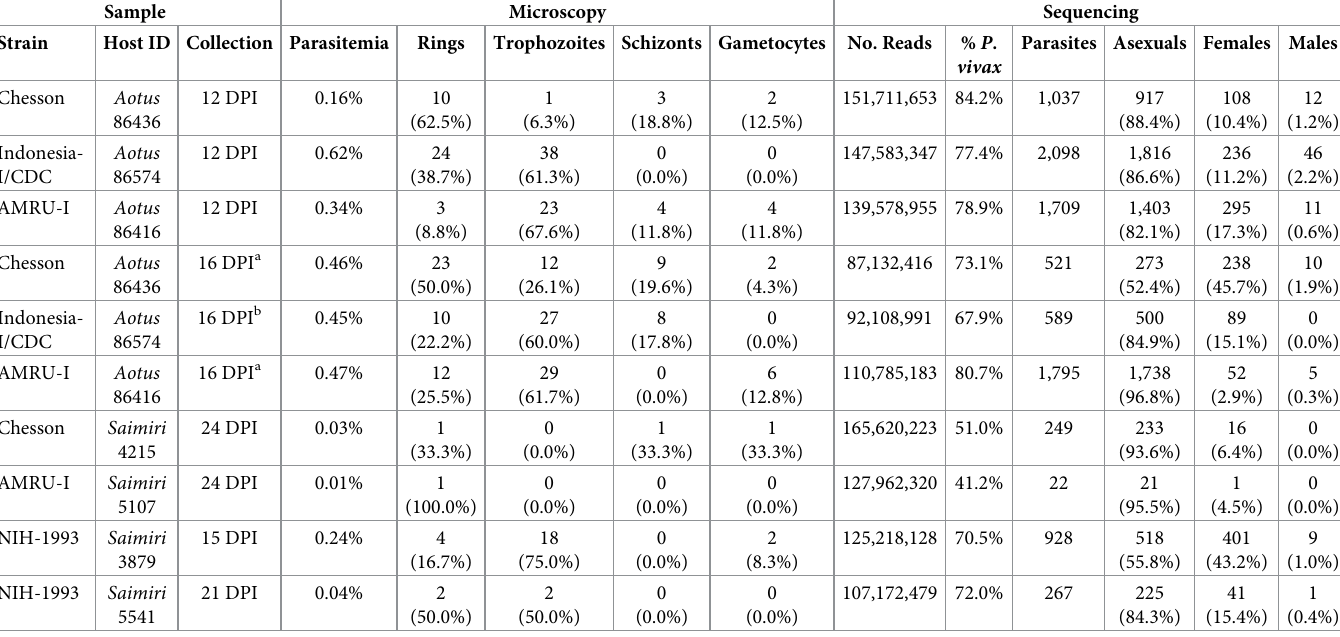
Table 1. Description of the samples and summary of the transcriptome data. The table shows information about the sample ( P . vivax strain, host species and animal identifier, and collection time in days post infection), microscopy data (parasitemia in percentage of infected RBCs, number of rings, trophozoites, schizonts and (female) gametocytes per 10,000 RBCs (and in %)) and sequencing data (number of reads generated, percentage of reads mapped to the P . vivax genome, number of individual par- asite transcriptomes obtained and number (and percentage) of asexual, female, and male